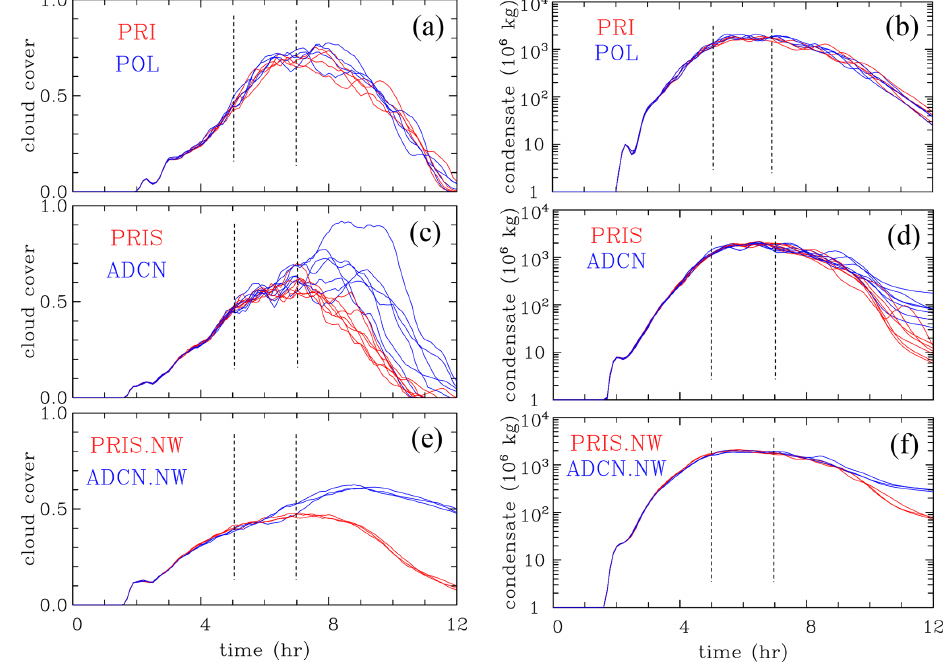
Figure 2. Evolution of (a, c, e) cloud cover and (b, d, f) total mass of cloud and precipitation inside the computational domain in (a, b) PRI and POL IAB ensembles, (c, d) PRIS and ADCN 2MOM ensembles, and (e, f) PRIS.NW and ADCN.NW 2MOM ensembles. Dashed vertical lines show the 6th and 7th hour period for which analyses are